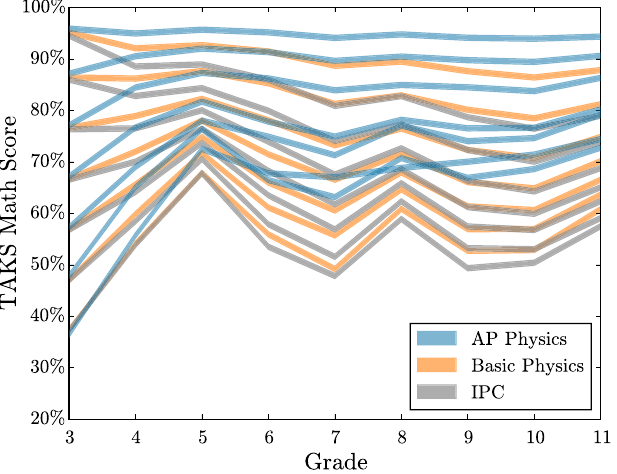
FIG. 4. Vector field of score changes and corresponding streamlines for the cohort of 2012. The students are sorted into new bins each grade, and the average change in score for each group is calculated from that grade to the next. The slope of an arrow is equal to the change in average score for that grade and bin. Streamlines are constructed, beginning with the average score in 3rd grade for each bin and then interpolating changes in score from the vector field to determine the slope of each segment of the streamline. These streamlines should capture the flow of student scores throughout the grades; however, the evident convergence of the streamlines due to RTM prevents this method from producing more meaningful